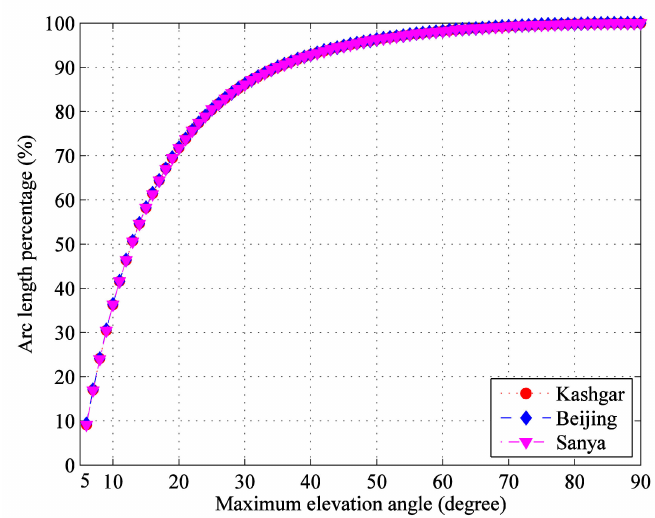
Figure 3. Cumulative distribution of transmission arc segments from the minimum 5 ◦ elevation